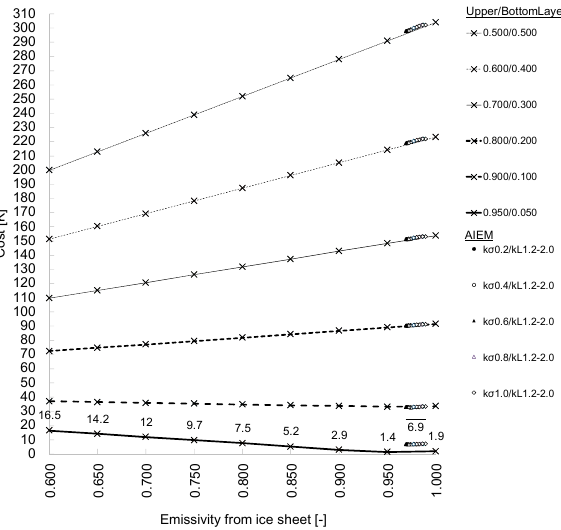
Figure 4. Comparison of costs for various surface conditions on the ice sheet over the wide satellite footprint covering the QH3 site. The vertical axis shows cost. The horizontal axis shows the assumed emissivity from the ice sheet (0.60, 0.65, 0.70, 0.75, 0.80, 0.85, 0.90, 0.95, and 1.00), while variables of the Advanced Integral Equation Model (AIEM), k σ (normalized surface root mean square height) ranges from 0.2 to 1.0 in 0.2 intervals, and kL (correlation length) ranges from 1.2 to 2.0 in 0.2 intervals. This yields the 25 cases of the AIEM plotted here for each emissivity. Snow structure reflects the six cases defined in the text, having upper/bottom layer thicknesses of 0.5/0.5 m, 0.6/0.4 m, 0.7/0.3 m, 0.8/0.2 m, 0.9/0.1 m, and 0.95/0.05 m. Snow particle radius (upper layer: R1 = 0.85 mm and bottom layer: R2 = 2.95 mm), snow density (upper layer: 0.10 g/cm 3 and bottom layer: 0.25 g/cm 3 ), and snow water content (SWC = 3 vol %) had fixed values.